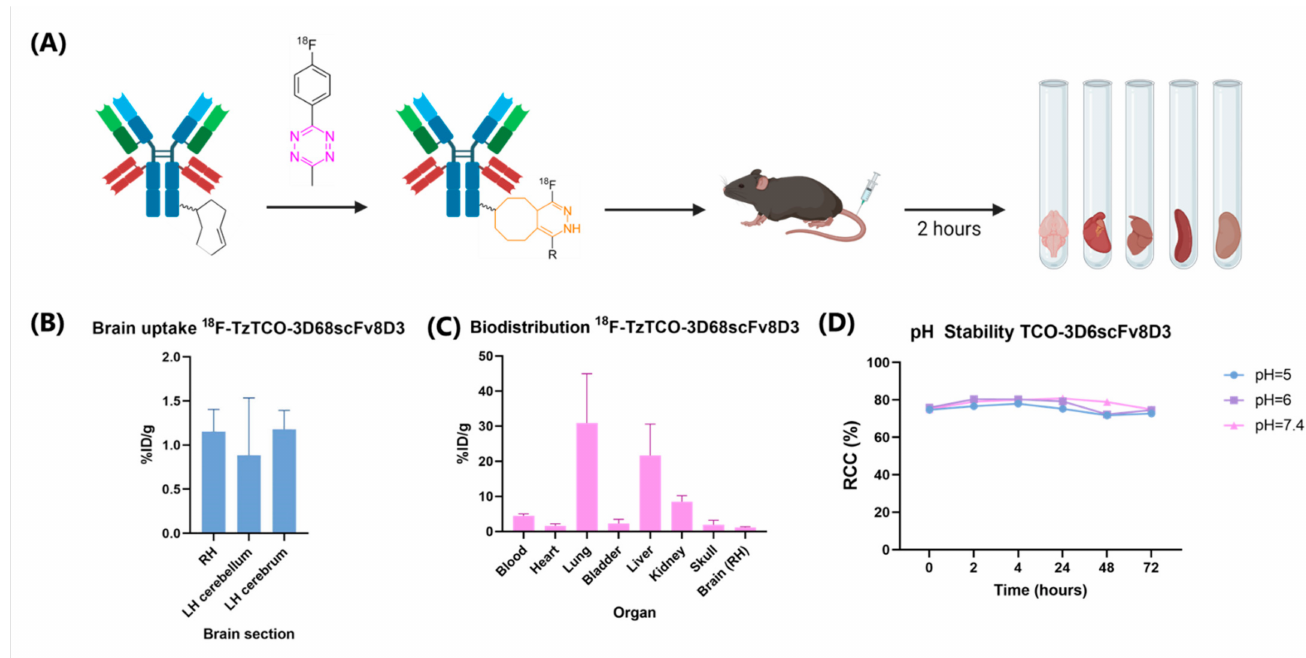
Figure 4. ( A ) Experimental setup biodistribution study. TCO-3D6scFv8D3 was reacted in vitro